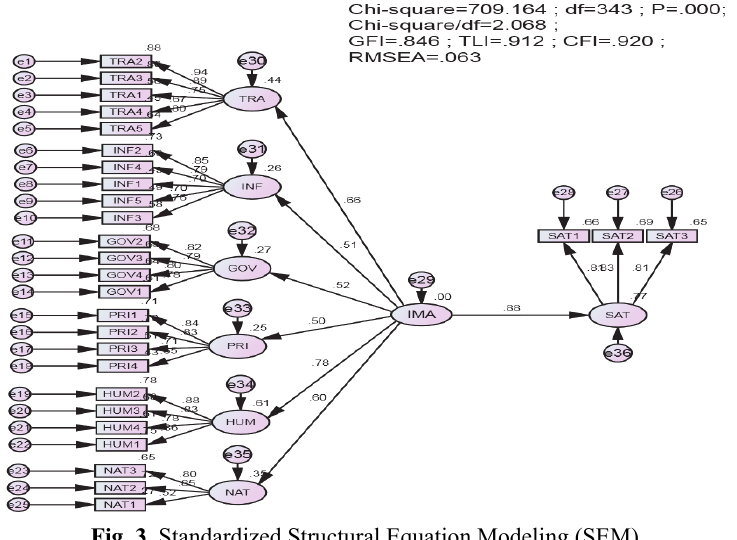
Fig. 3. Standardized Structural Equation Modeling (SEM)